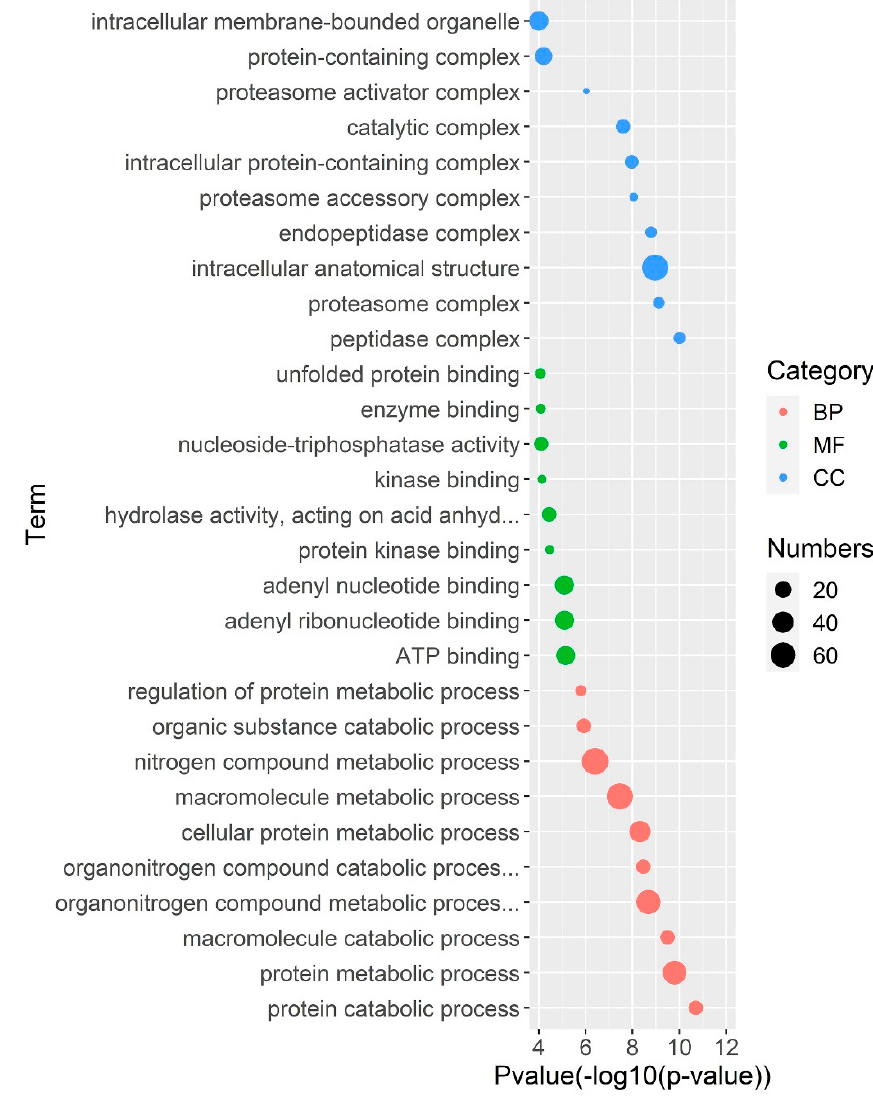
Figure 5. GO analysis of gene regulatory networks of the CiPS gene family members in grass carp. Note: Red dot BP, green dot MF, and blue dot CC represent three types of GO terms, including biological process, molecular function, and cellular component. The dot size represents the number of genes enriched in the GO term. The ordinate is the term of GO, and the abscissa is the p -value of topGO enrichment analysis, − log10 ( p ).